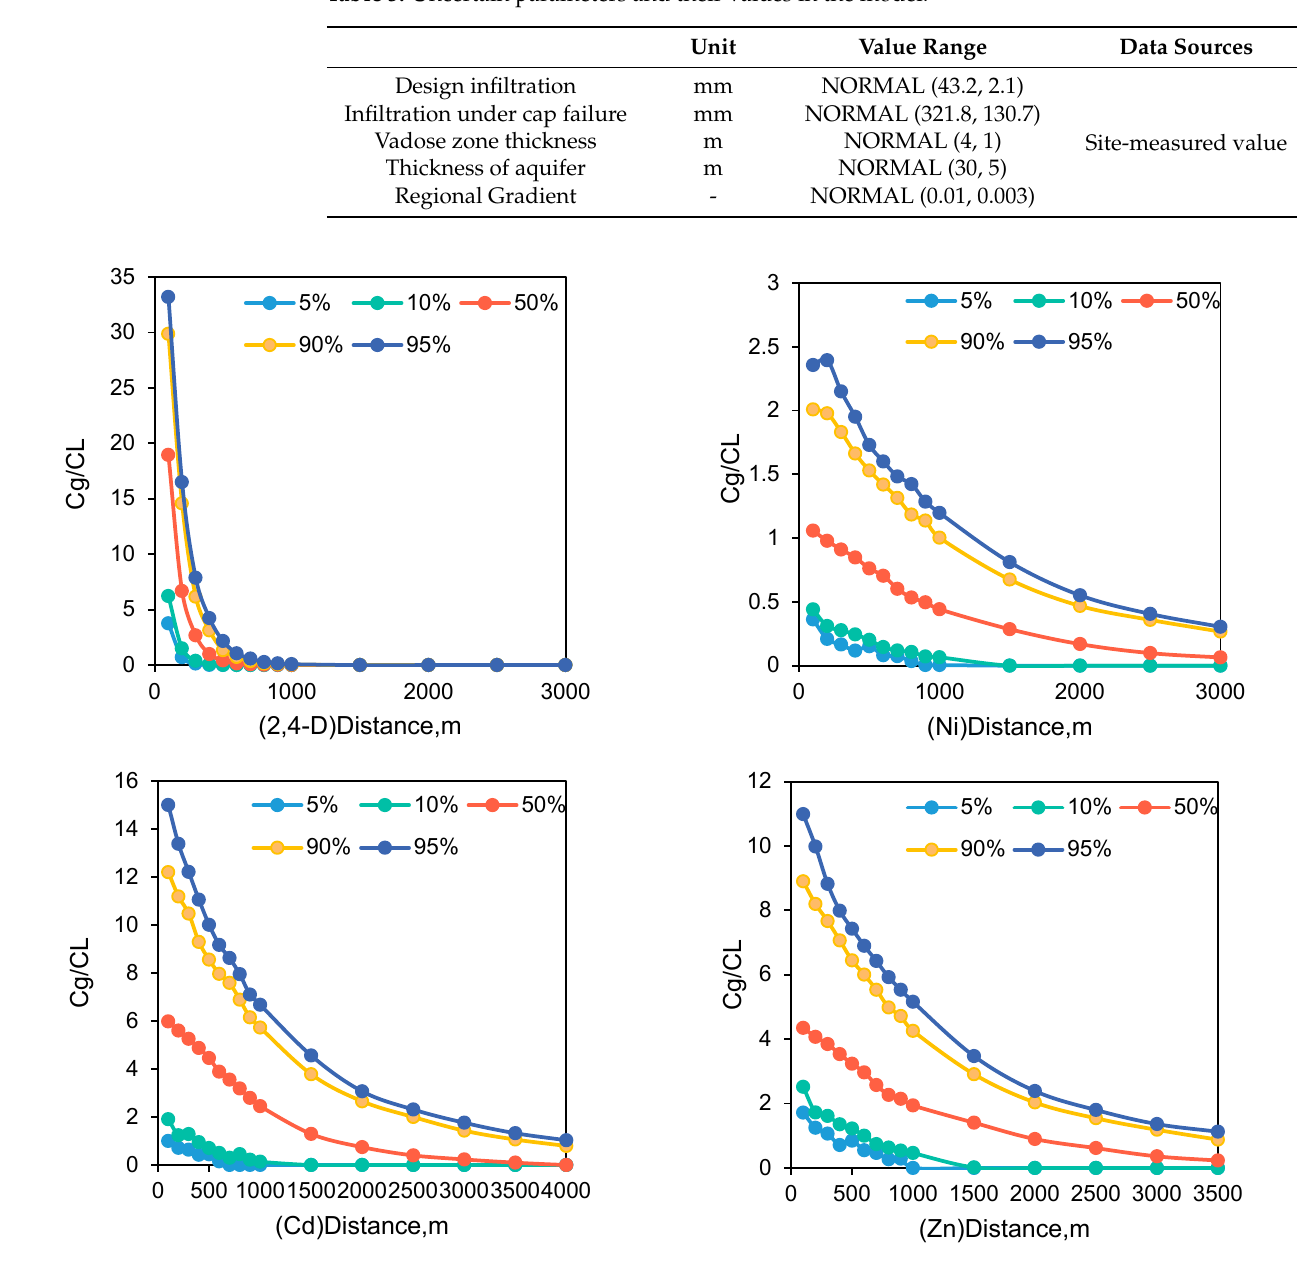
Figure 5. Long-term aging BFD of 2,4-D, Ni, Cd and Zn allowing for uncertainty.